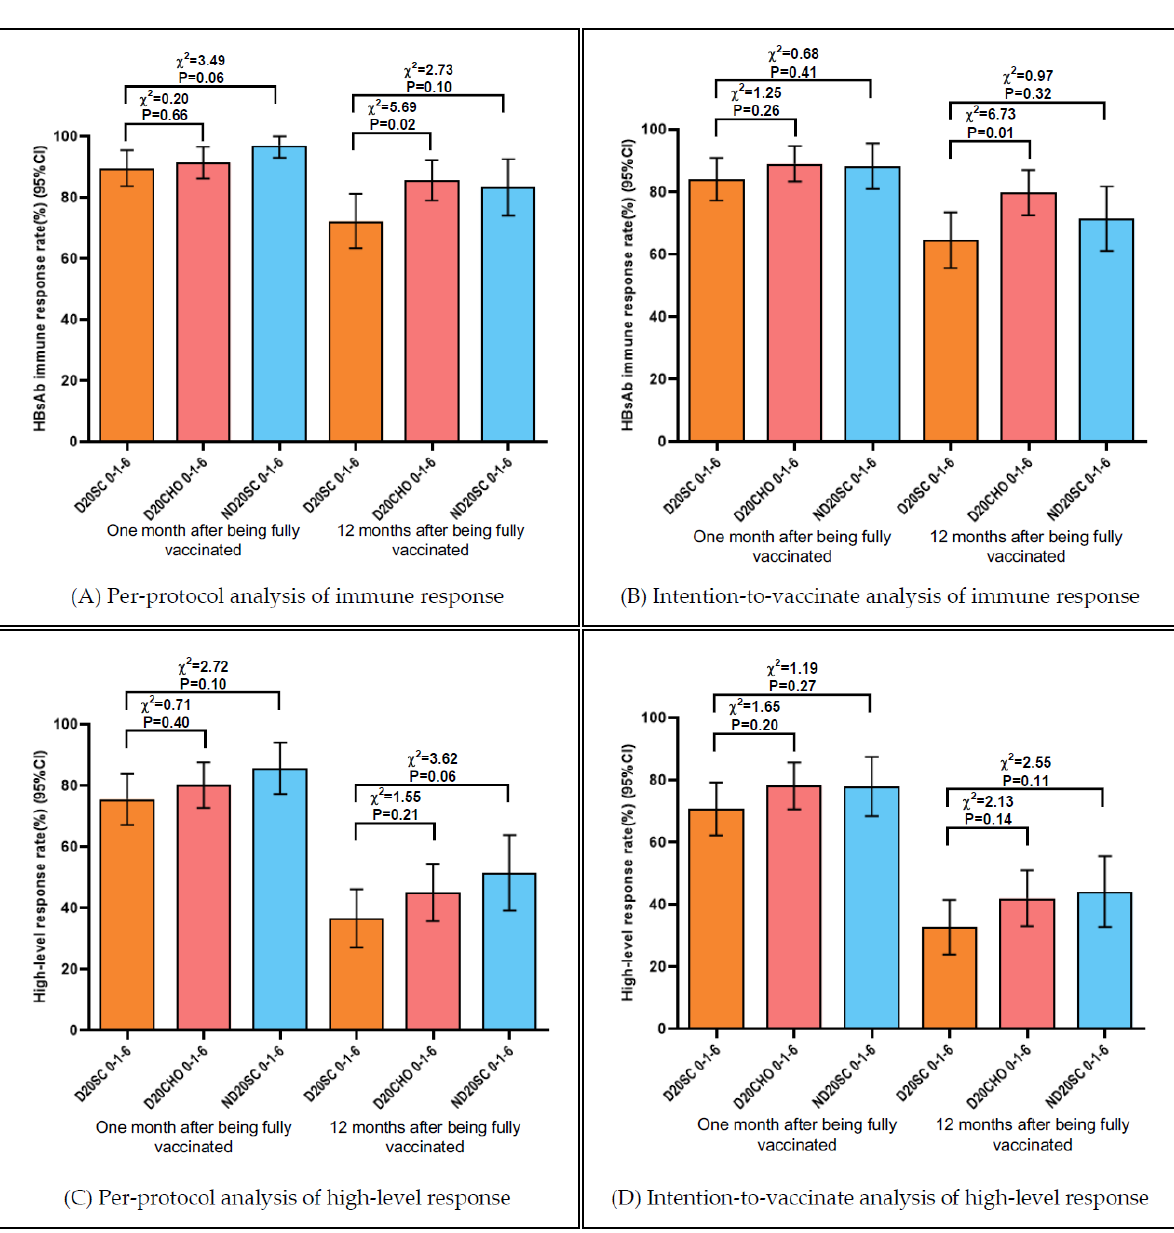
Figure 2. Immune response and high-level response at month 1 and 12 after vaccination in the intention-to-vaccinate and per-protocol analyses.